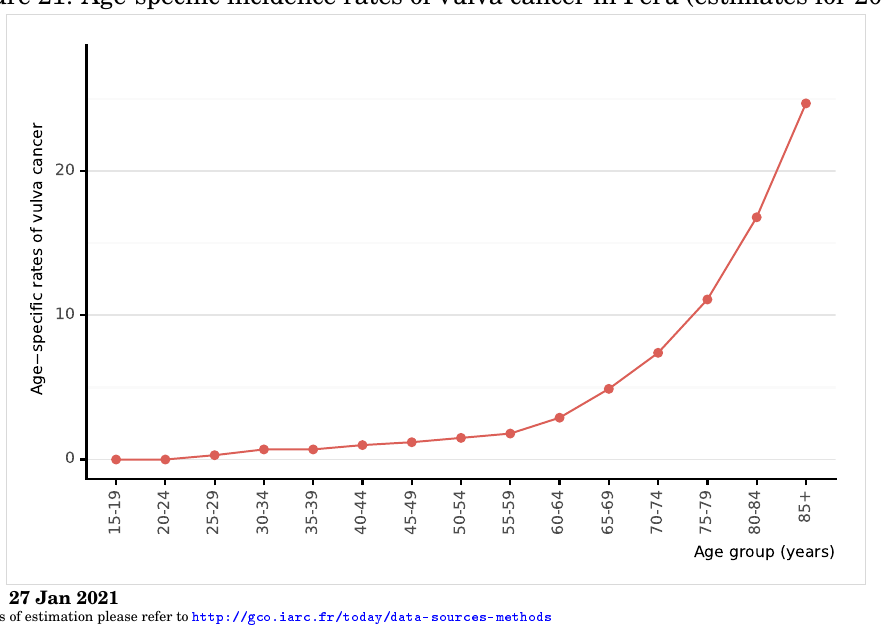
Figure 21: Age-specific incidence rates of vulva cancer in Peru (estimates for 2020)